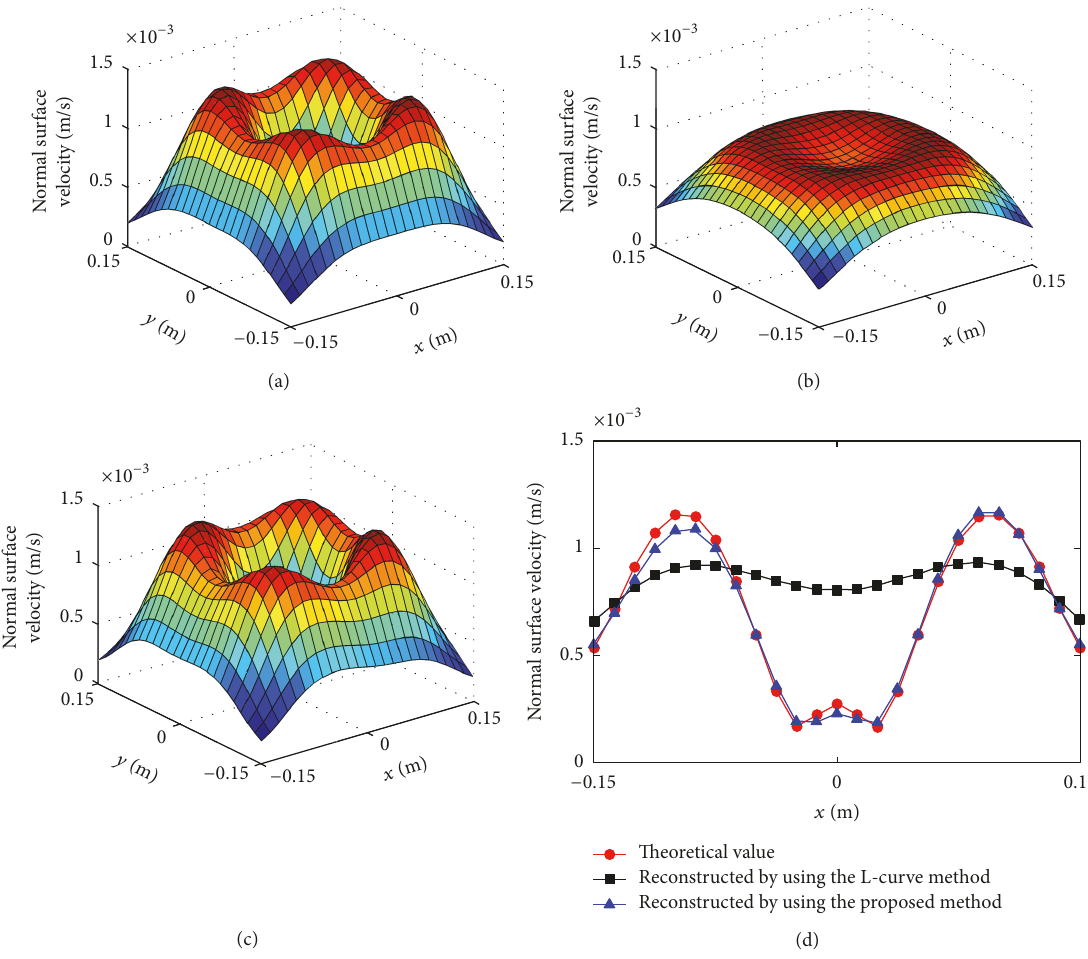
Figure 10: Comparison of reconstructed normal surface velocities at 600 Hz. (a) Theoretical value, (b) reconstructed by using the L-curve method, (c) reconstructed by using the proposed method, and (d) normal surface velocity along the middle row.